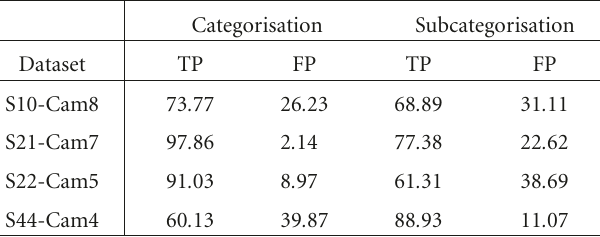
Table 6: Classification rates for object categorisation and object subcategorisation.